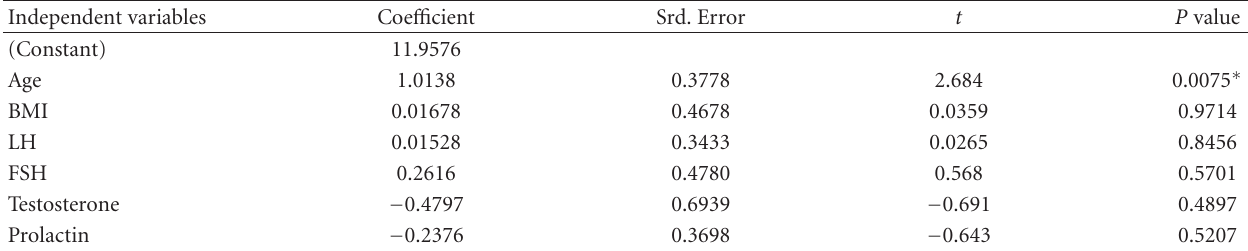
Table 4: Multiple regression to predict